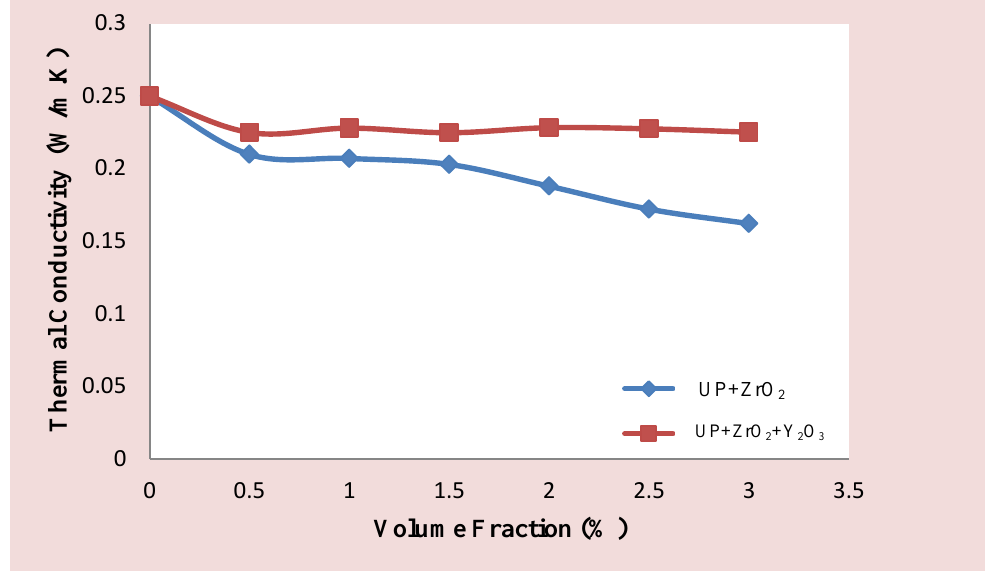
Fig .5: Thermal conductivity of the (UPE) nanocomposites as a function of the volume fraction of nanoparticles and hybrid nanoparticles content in the composite material.